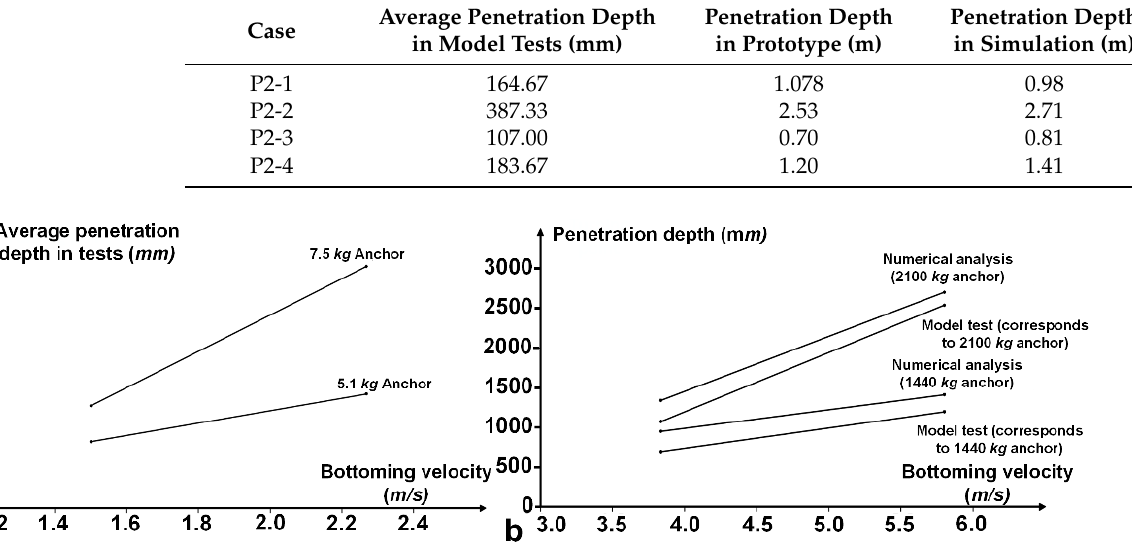
Figure 14. The penetration depth versus bottoming velocity and anchor weight. ( a ) The results in the model test ( b ) The numerical simulation results and the prototype results.